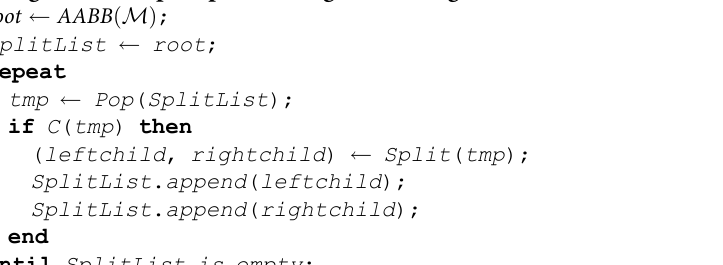
Algorithm 5: Space partitioning of M using the k-d tree